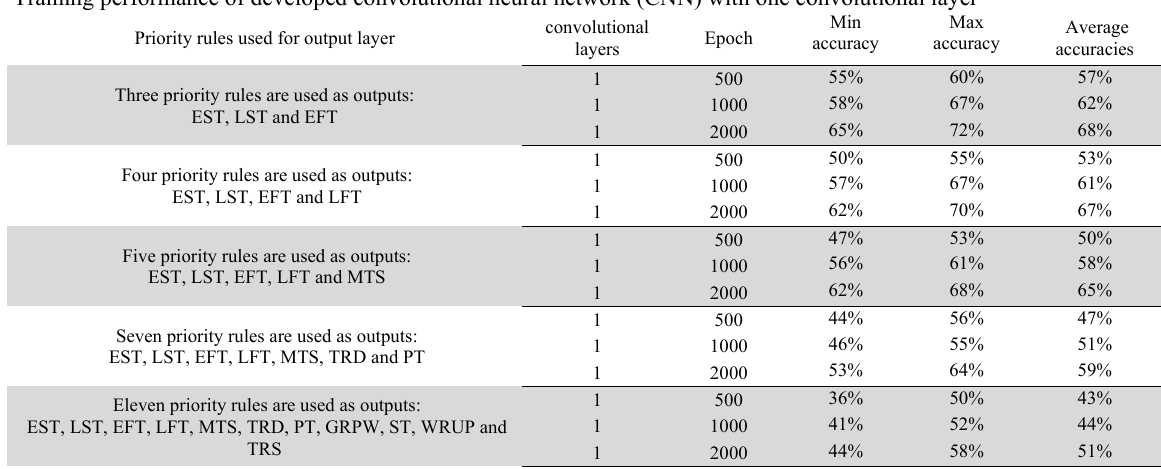
Training performance of developed convolutional neural network (CNN) with one convolutional layer Priority rules used for output layer